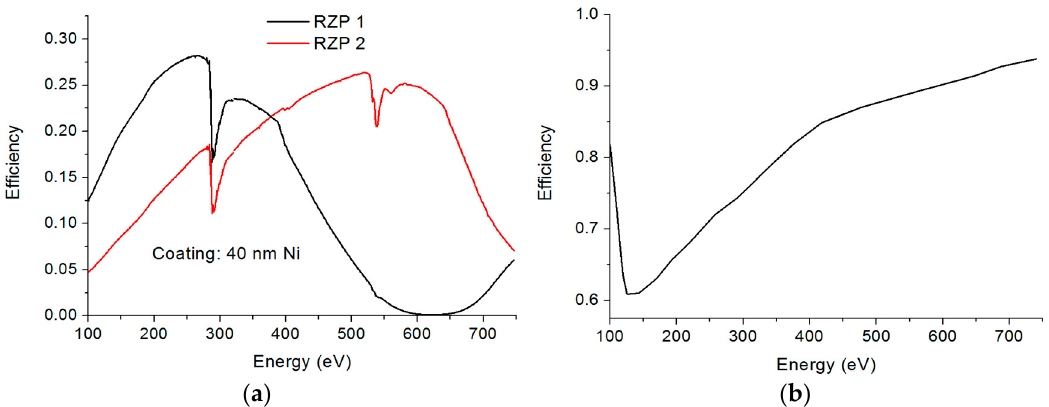
Figure 6. ( a ) Diffraction efficiency of RZP 1 and RZP 2, measured at the reflectometer of the synchrotron facility BESSY II [8]. ( b ) Quantum efficiency of the CCD “GE-VAC 2048 512 BI UV1” (greateyes GmbH) sensor [9].